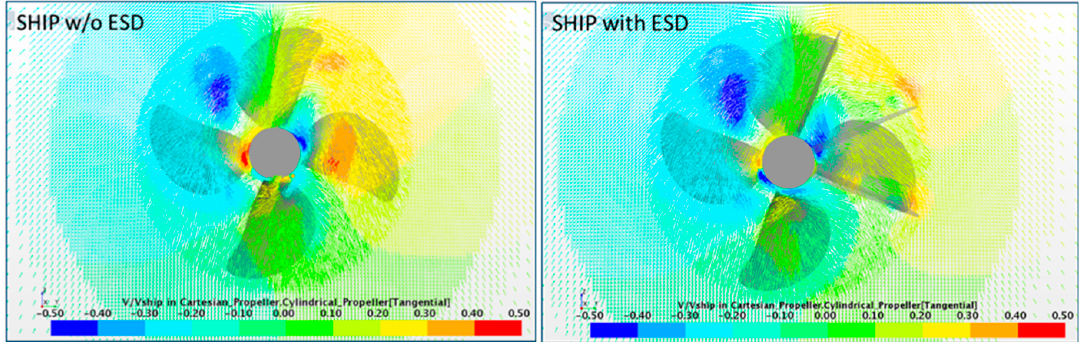
Figure 8. Distribution of the tangential velocity on section “Sect 1” in front of the propeller, seen from upstream (PSS-Var-5, full scale, Vs = 14 kn).